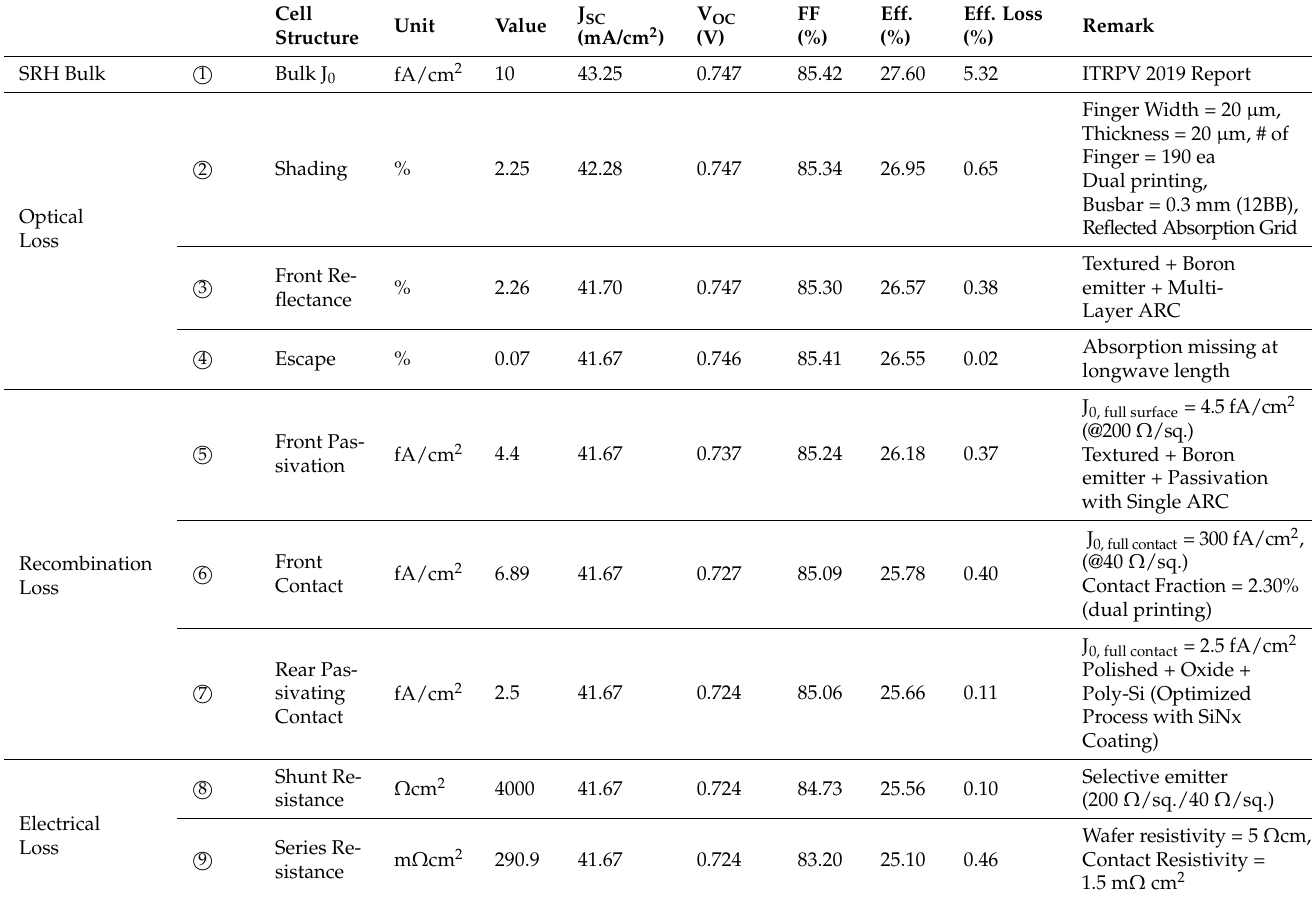
Table 1. Loss factor analysis of efficiency through various